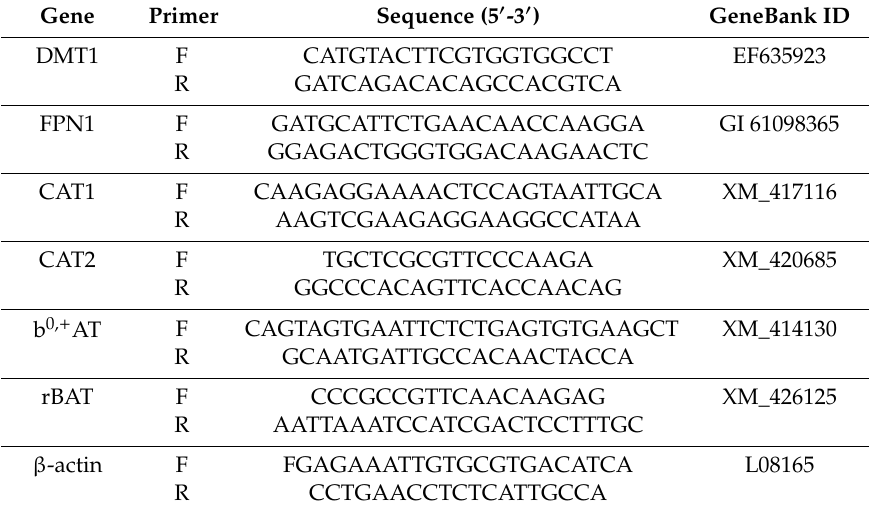
Table 1. The primers for quantitative real-time